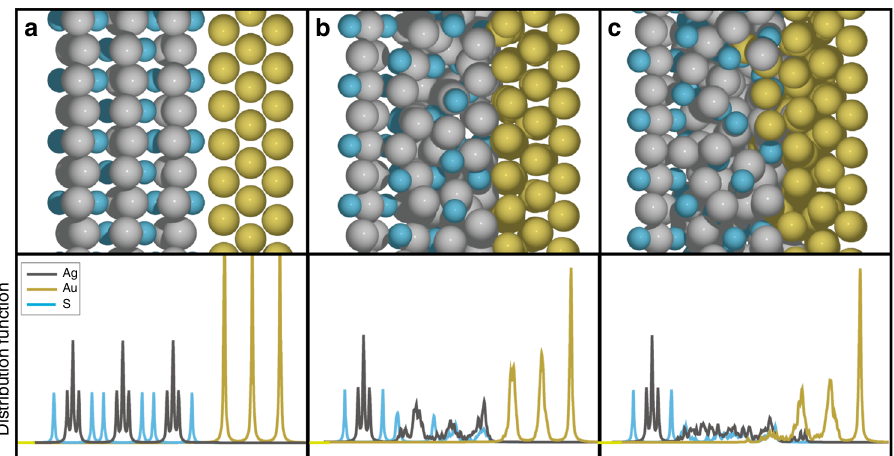
Fig. 3 Molecular dynamics simulation of the welding process. Snapshots (top) and element distribution pro fi les (bottom) of inter-facial region of the nanostructures a before welding, b after 16 ps simulation of welding at 300 K, and c after 16 ps simulation of welding at 800 K. Color: Ag — silver; Au — gold; S — cyan